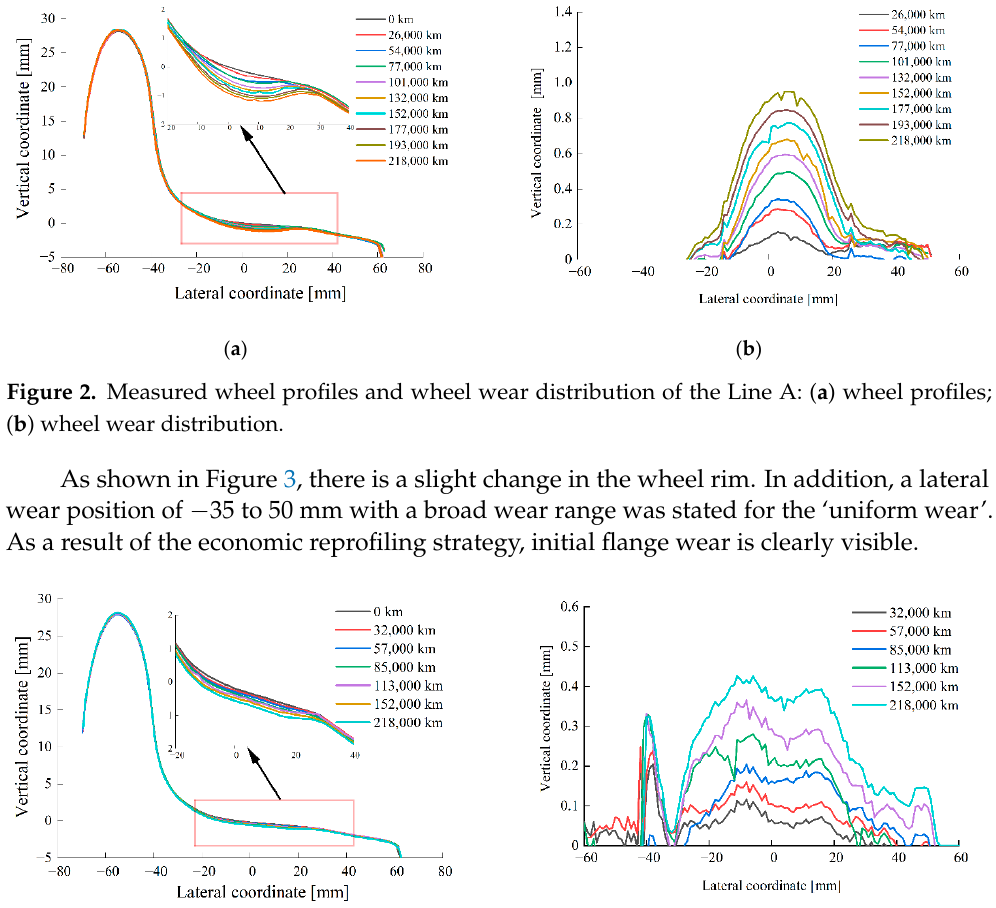
Figure 2. Measured wheel profiles and wheel wear distribution of the Line A: ( a ) wheel profiles; ( b ) wheel wear distribution.